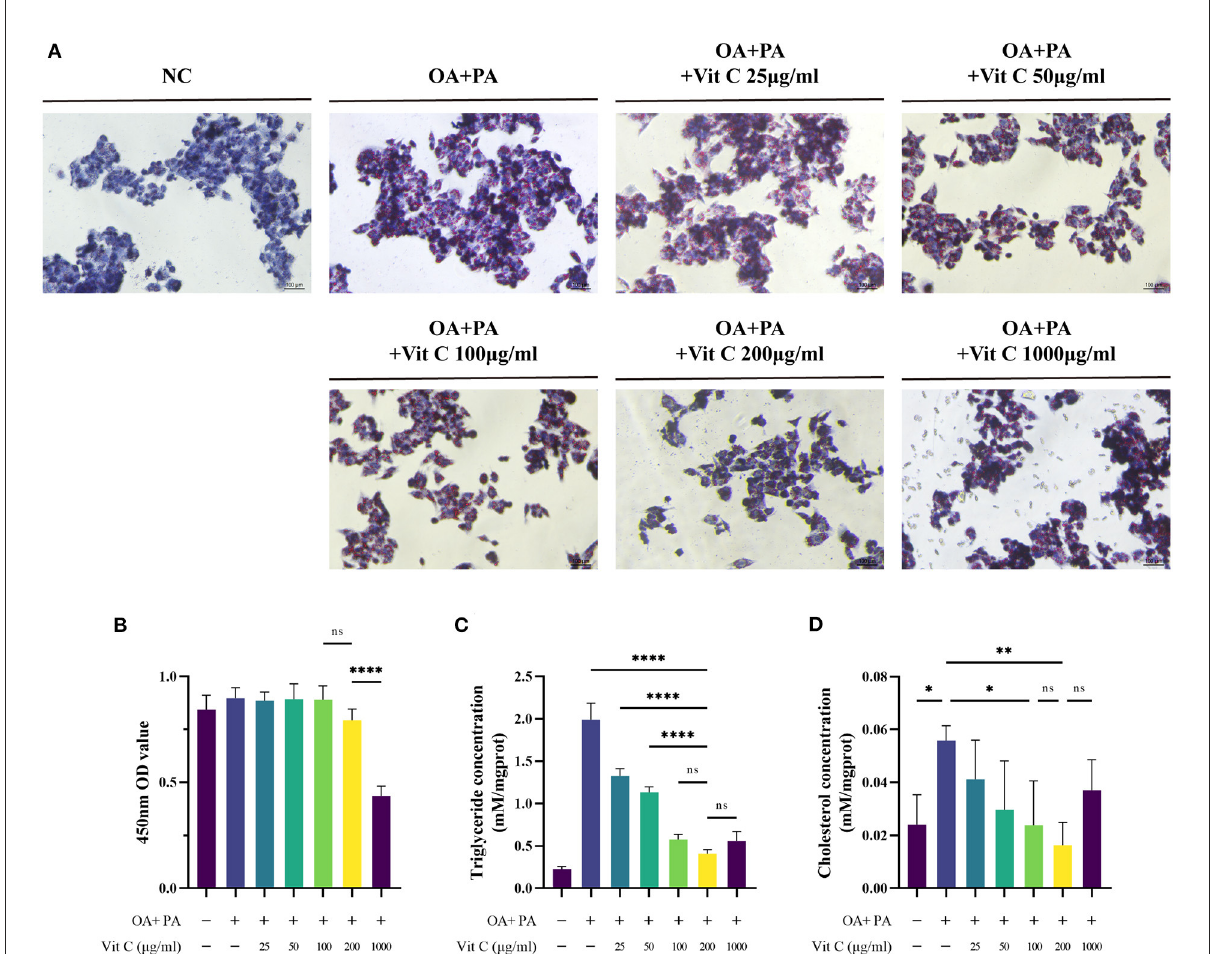
FIGURE4 Adding ascorbic acid (Vitamin C) to HepG2 cells in PA/OA culture reduces intracellular lipid deposition. (A) HEPG2 cells stained with Oil Red O, (B) CCK-8 assay for cell viability ( n = 5). (C,D) Triglyceride and cholesterol concentrations in the cells were detected after 24h ( n = 4). Values were presented as means ± SEM. * p < 0.05, ** p < 0.01, **** p <